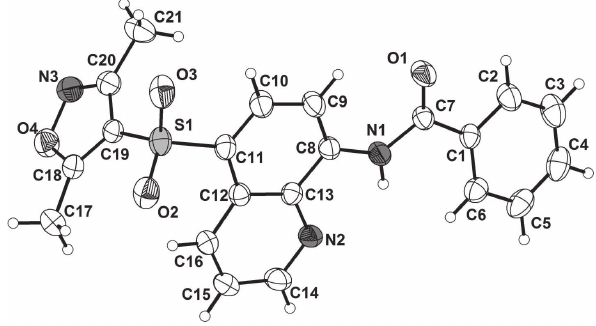
Table 1: Data collection and